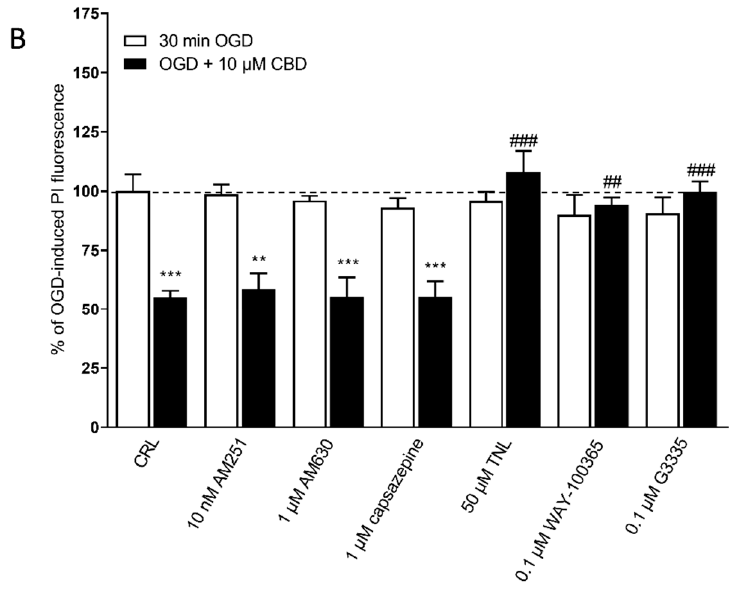
Figure 4. The effects of THC and CBD on OGD toxicity in rat organotypic hippocampal slices depend on different receptors. ( A ) The neurotoxic effects of 1 µ M THC on CA1 were completely prevented only by co-incubation with the CB1 receptor antagonists AM251. ( B ) On the other hand, the neuroprotective effect of 10 µ M of CBD was completely prevented by co-incubation with the TRPV2 antagonist tranilast (TNL), or 5HTA1 antagonist WAY-100635, or PPAR γ antagonist G3335, but not by the CB1 receptor antagonists AM251, the CB2 antagonist AM630, and the TRPV1 antagonist capsazepine. Bars represent the mean ± SEM of at least 5 experiments run in quadruplicate. * p < 0.05, ** p < 0.01 and *** p < 0.001 vs. OGD; ## < 0.01vs. OGD + THC for (A); ## < 0.01vs. OGD + CBD and ### < 0.001vs. OGD + CBD for (B) (one-way ANOVA plus Tukey’s w- test).